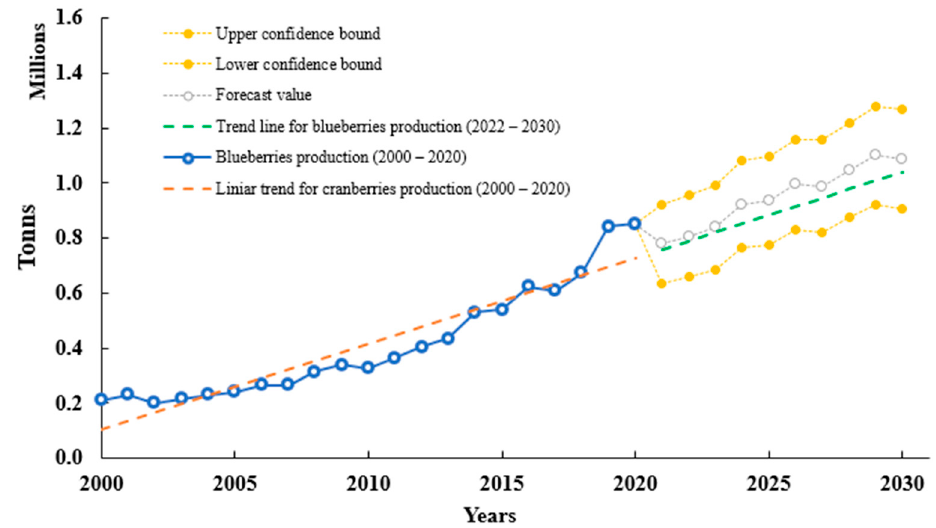
Figure 1. Evolution of world blueberry production over time. According to FAO, global blueberry production (tons) from 2000 until 2030 and TREND production until 2030. The trendline was calculated considering blueberry production every year from 2000 to 2030. The TREND function returns values along with a linear trend. It fits a straight line (using the method of least squares) to the arrays known_ys and known_xs. TREND returns the y-values along that line for the array of new_xs that you specify.